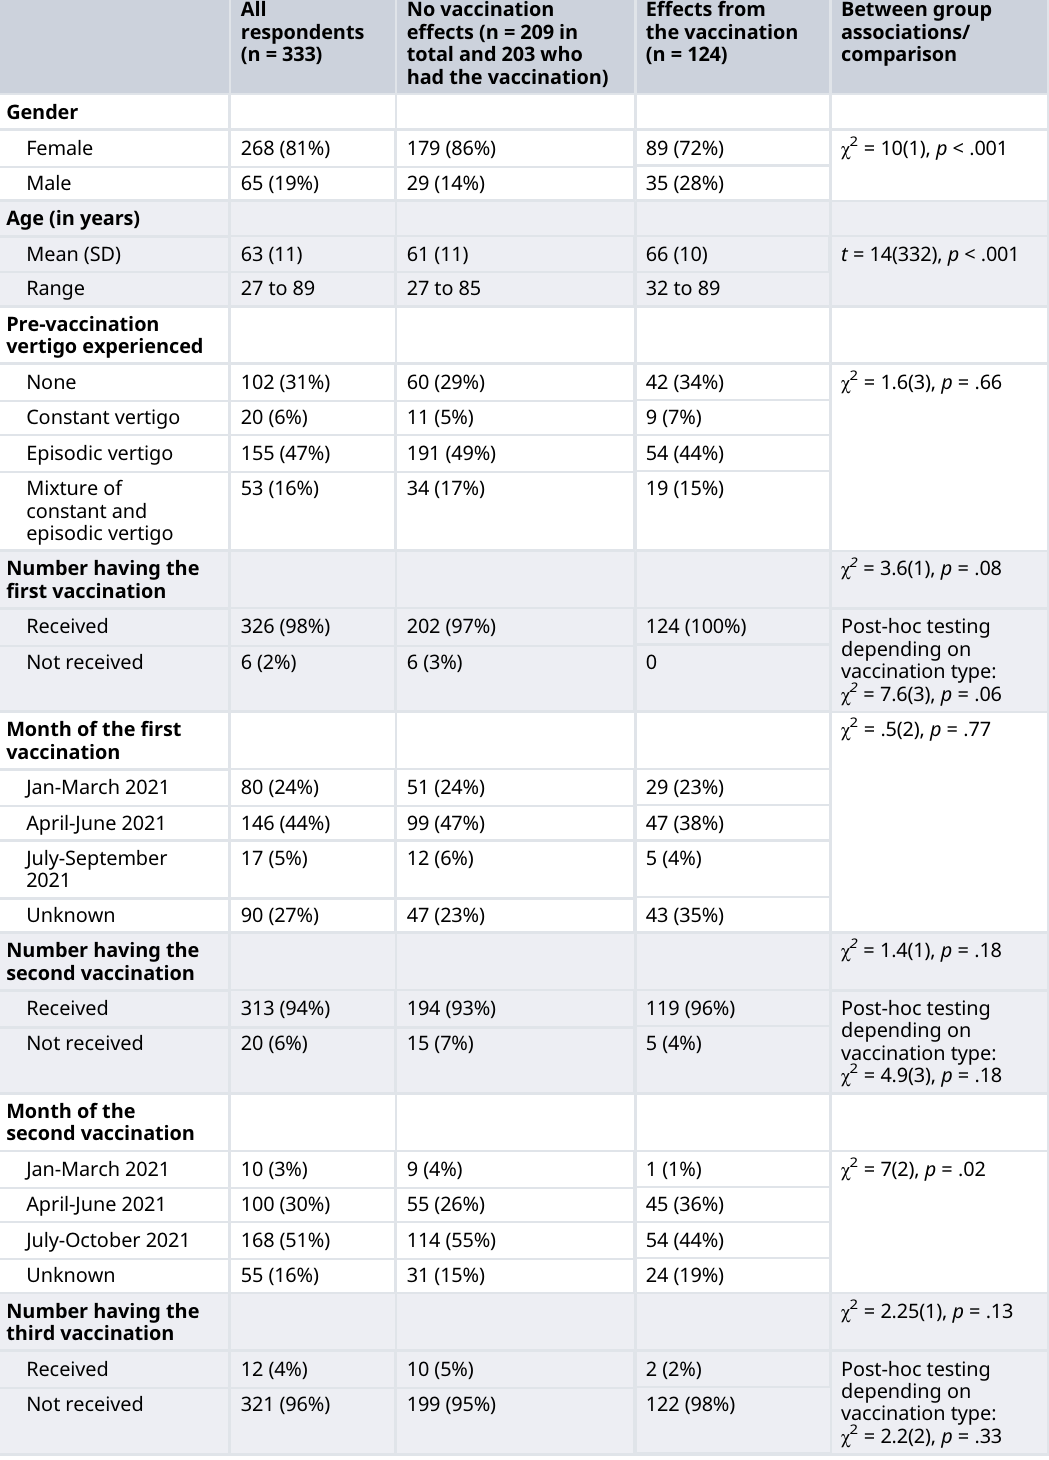
Effects from the vaccination (n = 124)